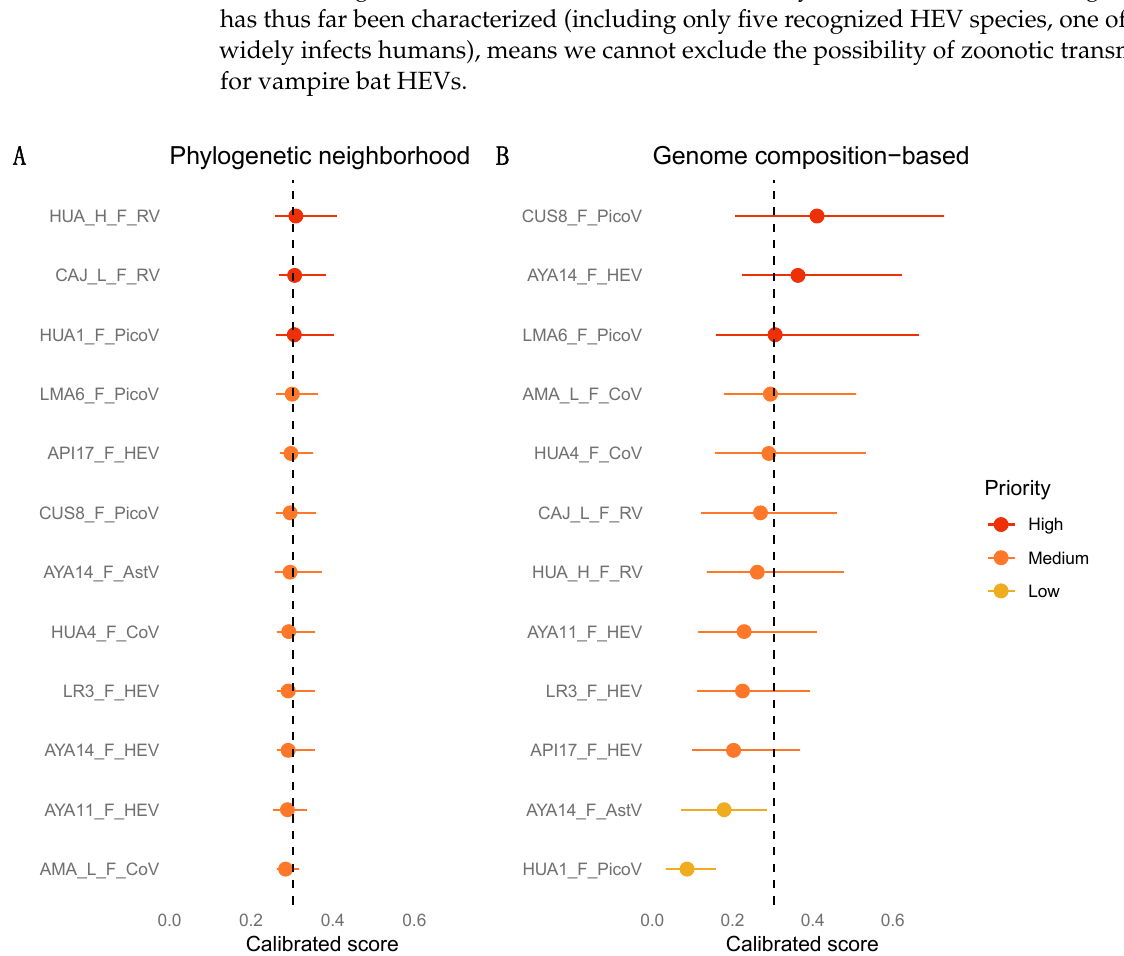
Figure 3. Prioritization of novel viruses based on zoonotic risk score. The figure shows the predicted probability of human infection for each novel virus based on ( A ) the phylogenetic neighborhood model and ( B ) genome composition-based model. Viruses are colored and ordered according to predicted probability of infecting humans. Points show the mean calibrated score, with lines indicating 95% confidence intervals. The dashed line indicates a cutoff of 0.303, which balances sensitivity and specificity. Predicted scores and confidence intervals from machine learning models were used to categorize viruses into four possible priority categories.